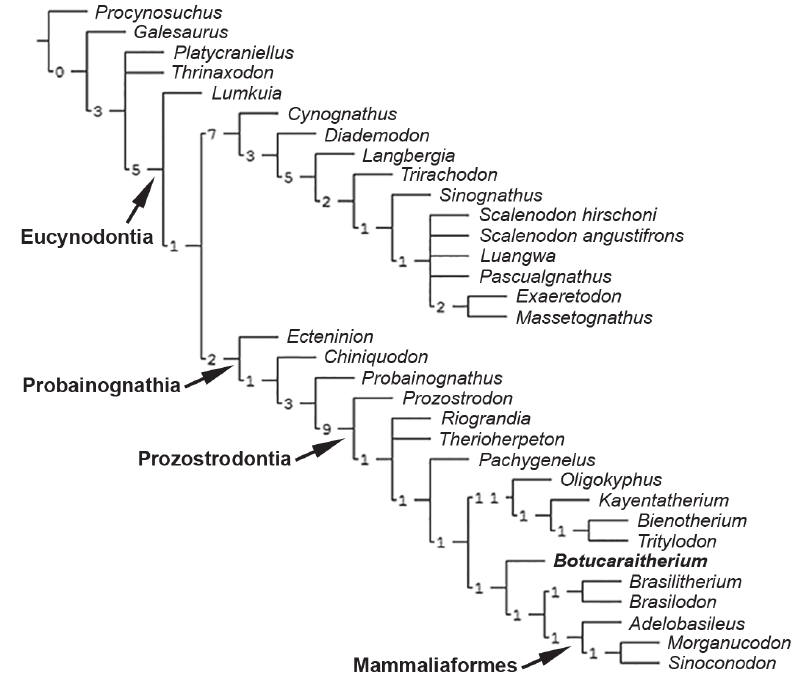
Fig. 7 - Strict consensus tree with Bremer index, positioning Botucaraitherium belarminoi gen. nov. et sp. nov as a derived